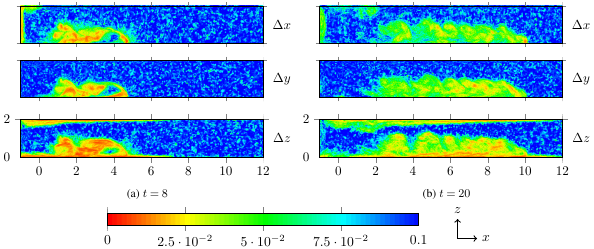
Fig.9:Heatmapindicatingthesizeoftheelementsin x , y and z acrossaplaneat y =1 forasubsetofthedomain( − 1 <x< 12 )andtimes t =8 (left)and t =20 (right).Notethatthedomainextendsto x =18 .Theregion 12 <x< 18 hadnosignificant regionswithelementsizessmallerthan 0 . 1 .